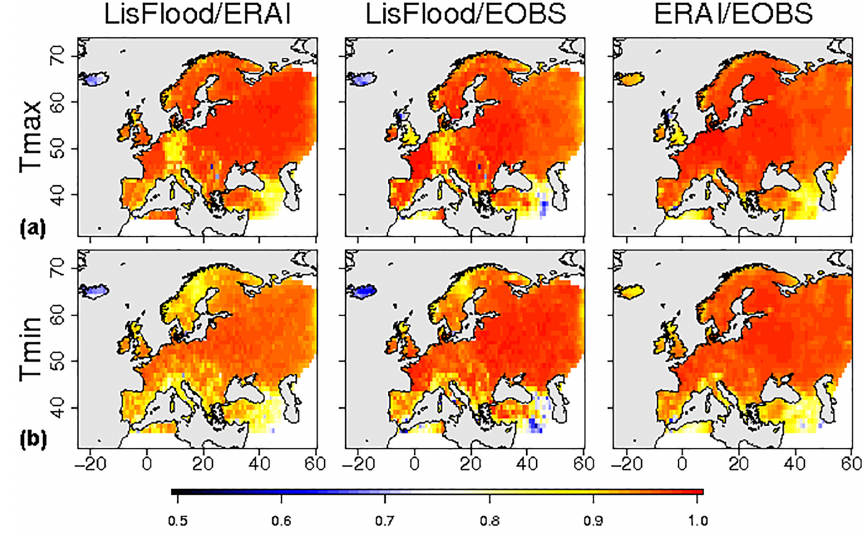
Figure 2. Temporal correlation of the temperature quantiles of T min (a) , and T max (b) provided by ERAI, EOBS and LisFlood datasets from 1995 to 2015. The datasets compared are indicated on the top of each column.